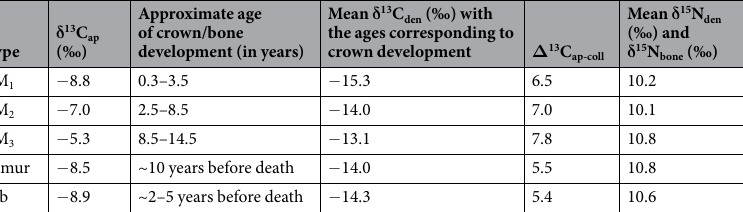
Table 2. Carbon isotope values from the enamel apatite and dentin collagen, and mean nitrogen isotope values of dentin collagen. Note: 1. The mean δ 13 C den values refer to the isotopic average of dentin sections with the age corresponding to the crown of each tooth. 2. The mean δ 15 N den values refer to the isotopic average of whole dentin sections of each